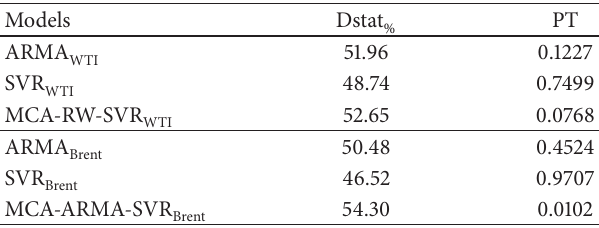
Table 3: Pesaran-Timmermann directional